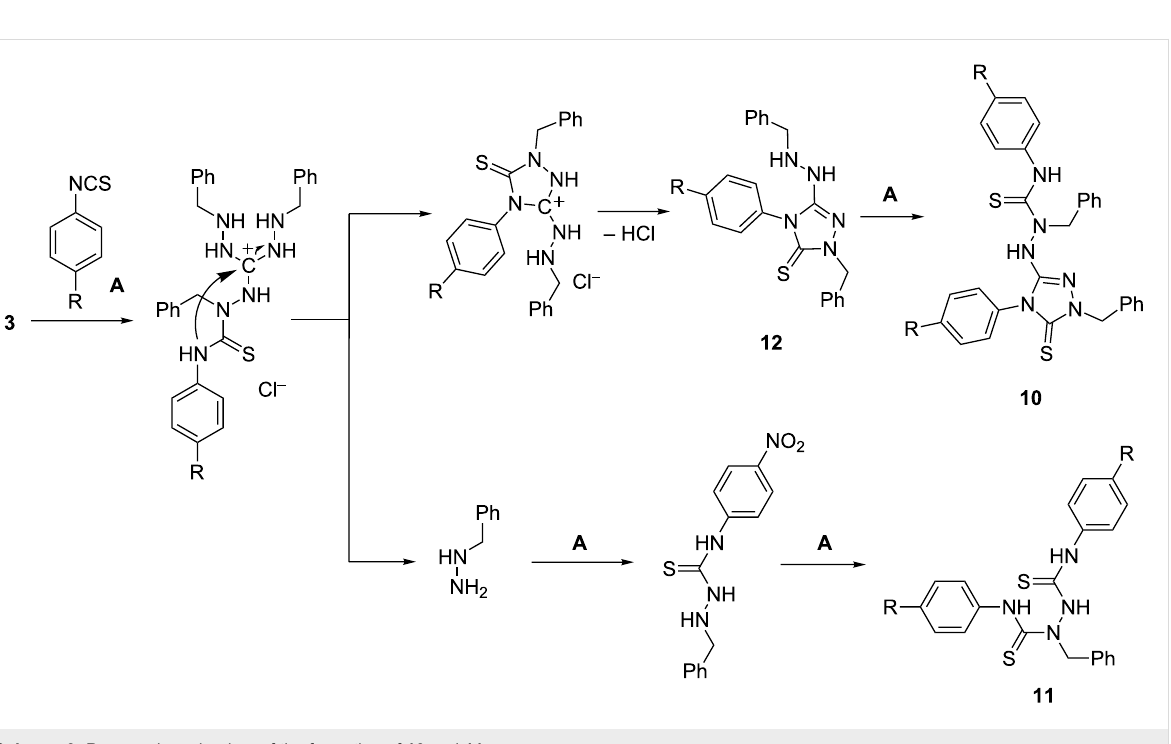
Scheme 6: Proposed mechanism of the formation of 10 and 11